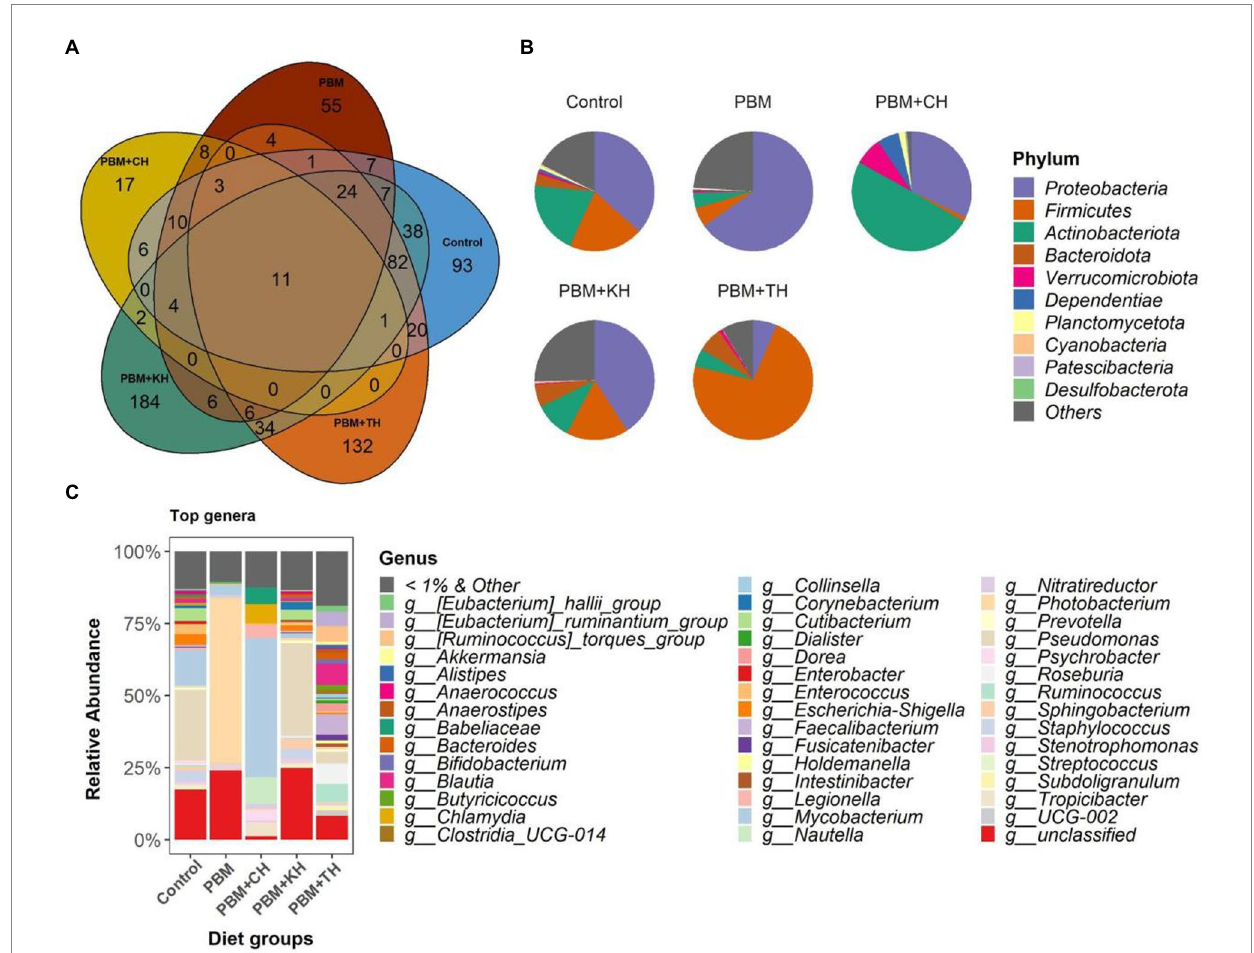
FIGURE 4 Gut bacterial composition in the intestine of barramundi fed FM-based control, PBM alone or supplemented with various FPHs supplemented diet over a period of 42 days. (A) The number of shared, unique and core genera in five different feeding groups. (B) Pie-chart representing the relative abundance of bacteria at phylum-level. (C) Relative abundance of top 1% genera in five different feeding